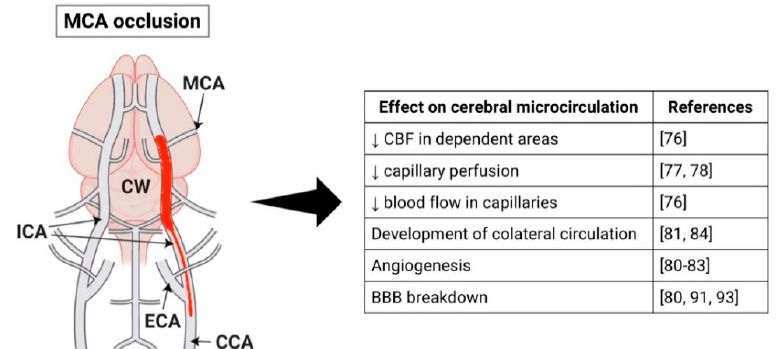
Figure 1. Schematic representation of the middle cerebral artery (MCAO) stroke model and its effects on the cerebral microcirculation. Figure created with Biorender (https://biorender.com).